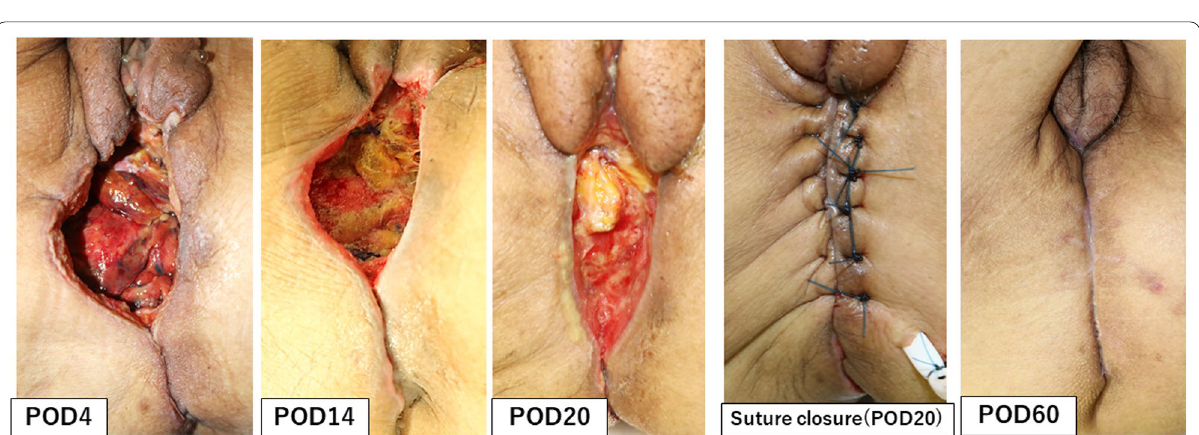
Fig. 4 Healing of the perineal wound. Granulation tissue formed gradually in the pelvic dead space. The skin was closed on postoperative day